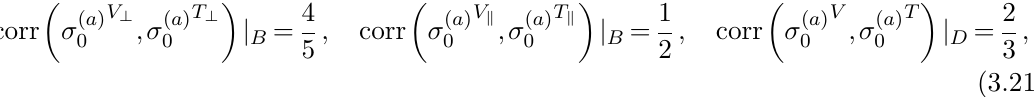
/m 2 ≈ 1 . 02 and B ∗ B for the ⊥ - and k -directions 0